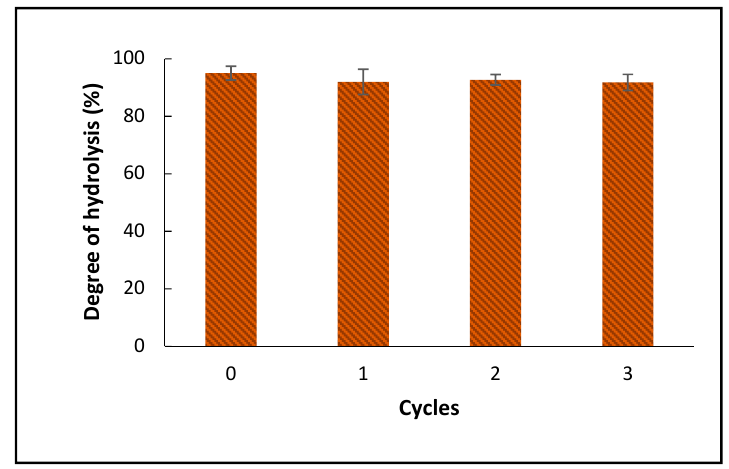
Figure 7. The e ff ect of water recycling on the hydrolysis of Schizochytrium sp. oil. Conditions: Temperature 220 °C, pressure 2.8 Mpa, water to oil ratio 10:1 (w:w), 150 rpm.